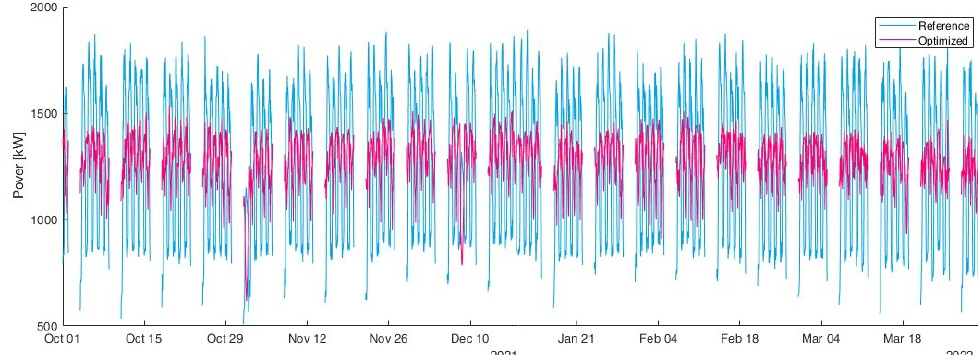
Figure 13. Comparison between the reference unoptimised load (in blue) with the optimised one (in purple).